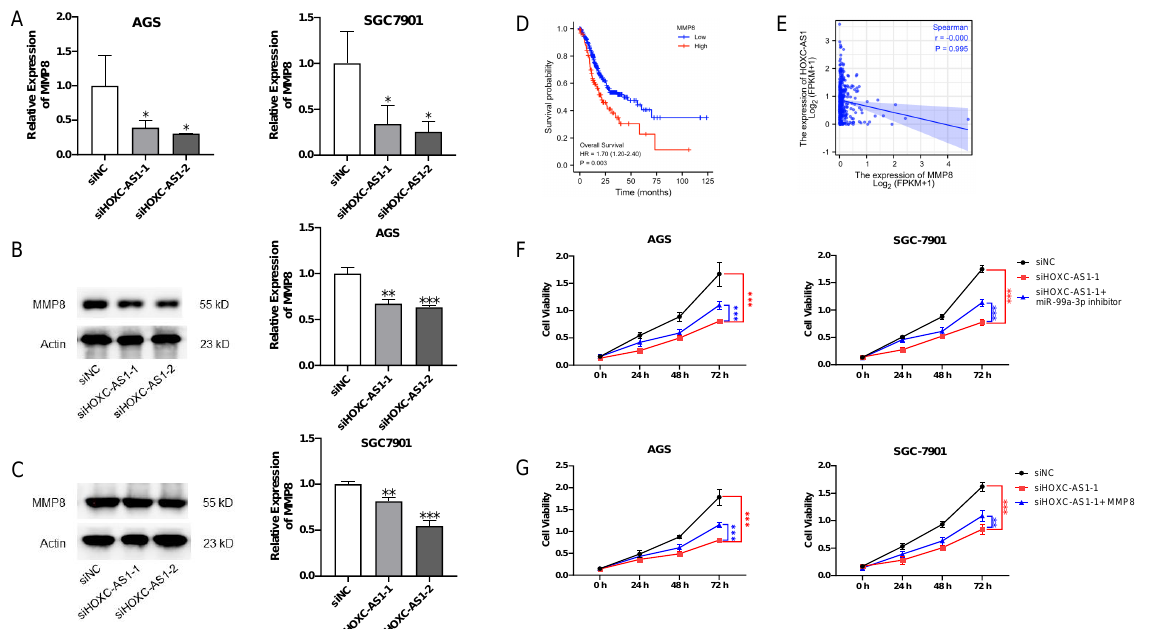
Figure 5. HOXC-AS1 promoted cell progression of GC by targeting the miR-99a-3p/MMP8 axis. ( A ) The expression of MMP8 following downregulation of HOXC-AS1 by qRT-PCR. ( B , C ) MMP8 expression following downregulation of HOXC-AS1 in AGS and SGC7901 cell lines by western blot. Full blotting could be found at Figures S4–S7. ( D ) Kaplan–Meier analysis for overall survival of GC patients based on the expression of MMP8. ( E ) The correlation of HOXC-AS1 and MMP8. ( F , G ) Rescue experiment of CCK-8 through co-transfecting miR-99a-3p inhibitor or overexpressing MMP8 in AGS and SGC7901. SiNC and siHOXC-AS1 were transfected as control. * p < 0.05; ** p < 0.01; *** p <